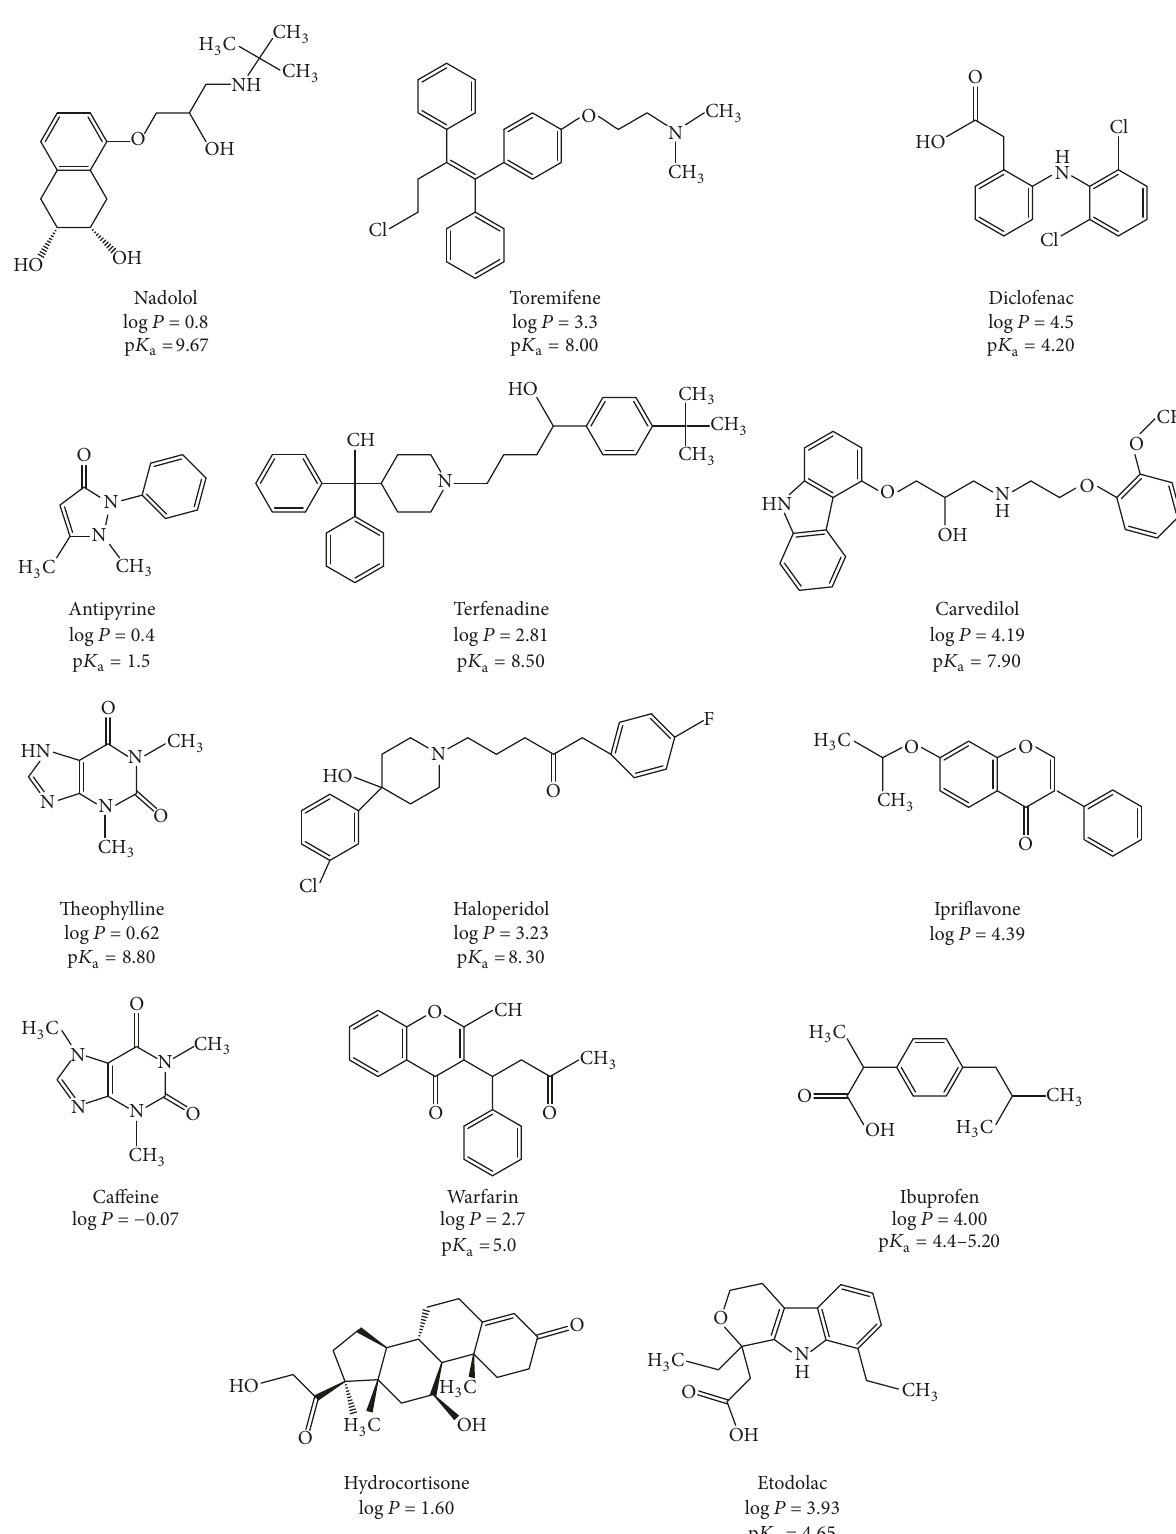
Scheme 1: Structures of the 14 drugs with their known physicochemical